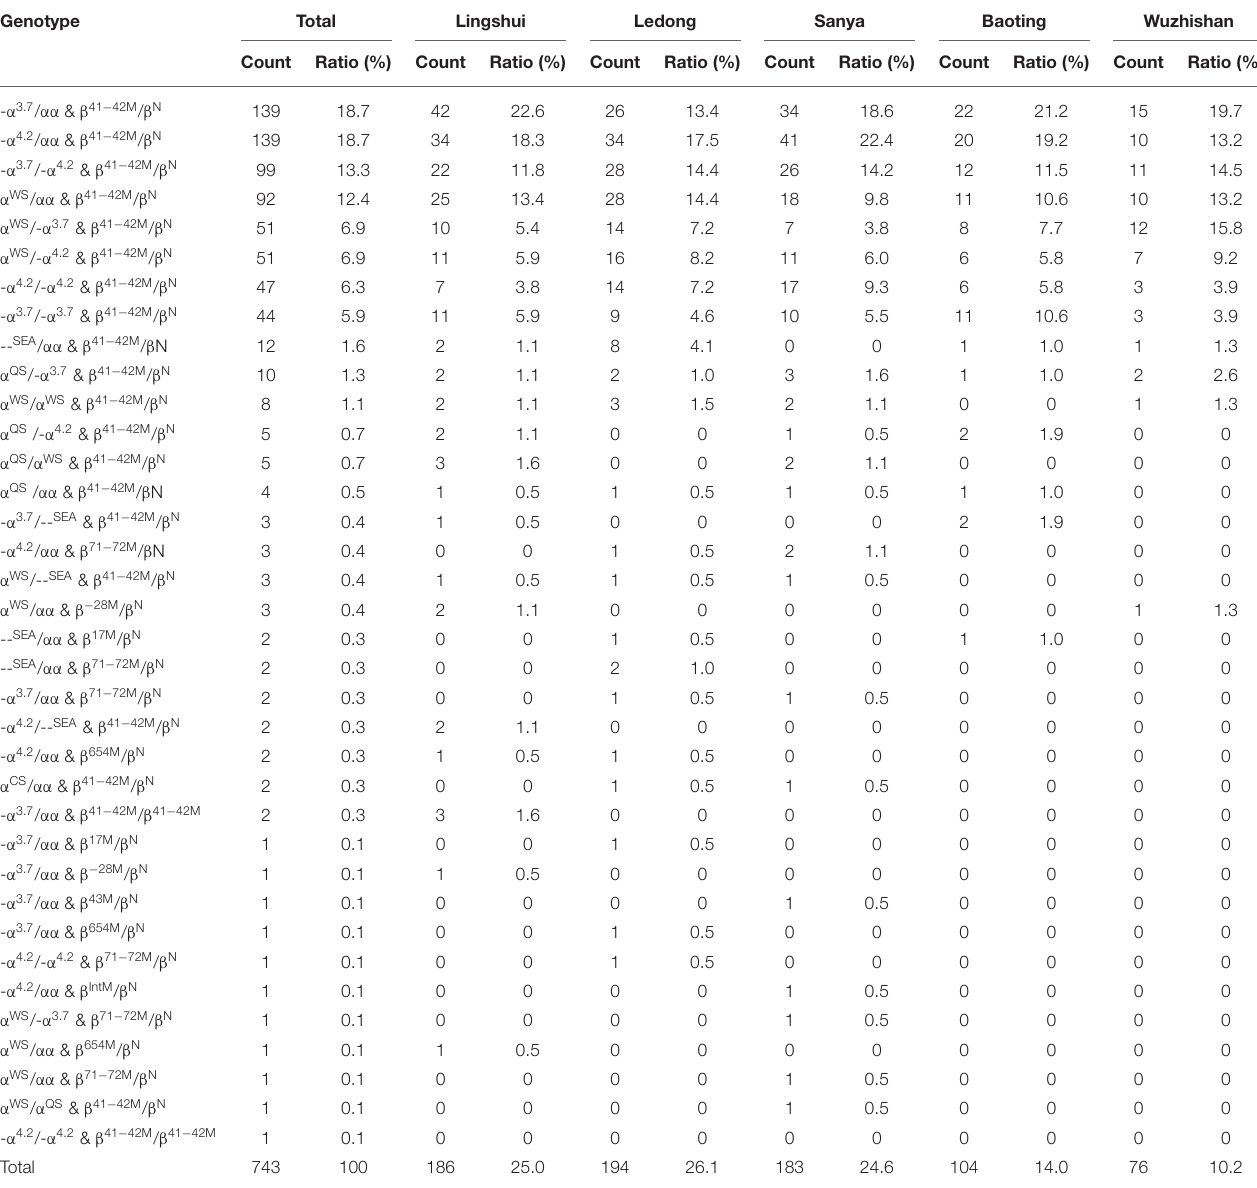
TABLE 3 | Distribution of α -composite β -thalassemia genotypes in the southern area of Hainan. Genotype